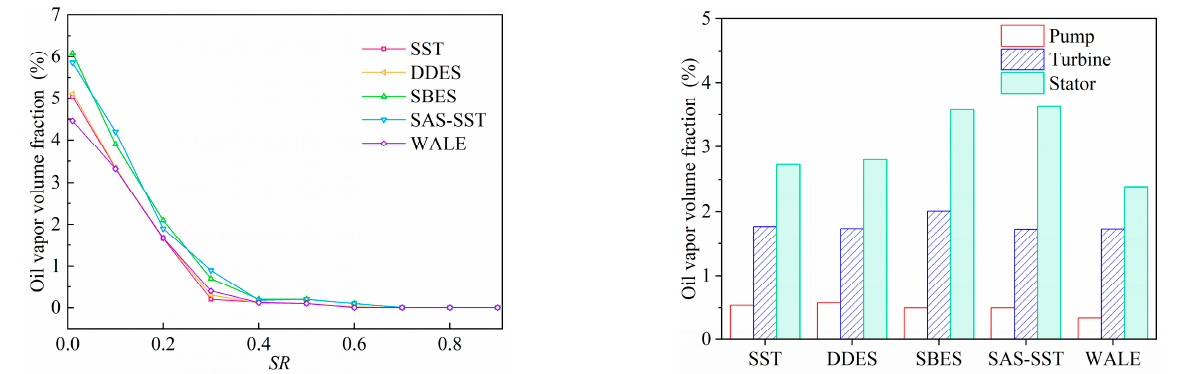
Figure 10. Vapor volume fraction distribution under various SR ( left ) and vapor volume fraction in different domains ( right ).